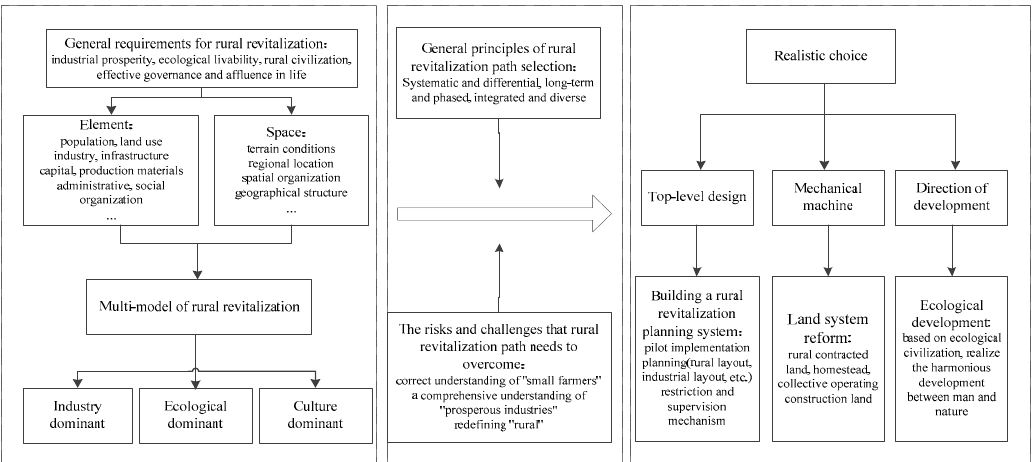
Figure 3. Path selection strategy chart for rural revitalization. Source: Authors, based on the